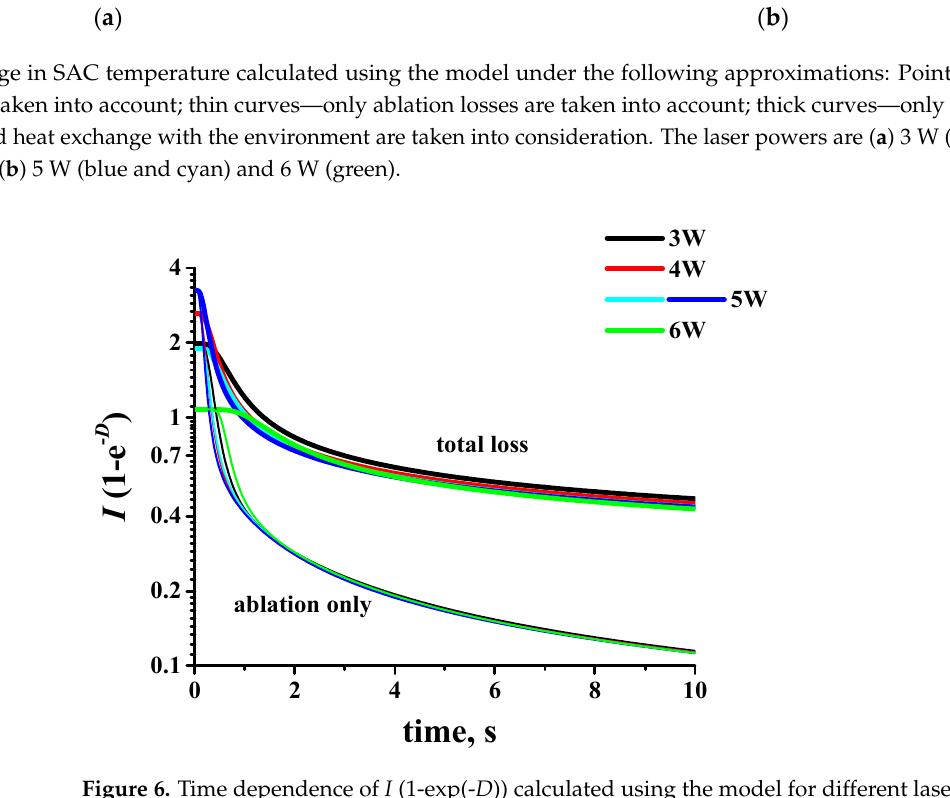
Figure 6. Time dependence of I (1-exp(- D )) calculated using the model for different laser powers P : 3 W (black), 4 W (red), 5 W (blue and cyan), and 6 W (green). Thick curves correspond to the results when all types of losses in the system are taken into account, and thin curves when only ablation is taken into consideration.